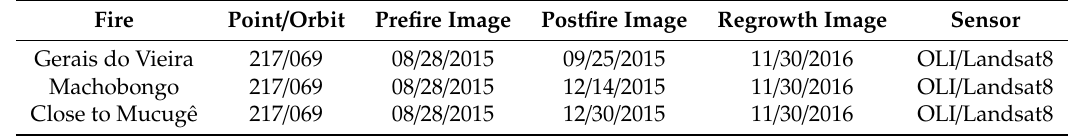
Table 1. Characteristics of the operational land imager (OLI) / LANDSAT-8 images. Fire Point / Orbit Prefire Image Postfire Image Regrowth Image Sensor Gerais do Vieira 217 / 069 08 / 28 / 2015 09 / 25 / 2015 OLI / Landsat8 Machobongo 217 / 069 Close to Mucug ê 217 / 069 08 / 28 /